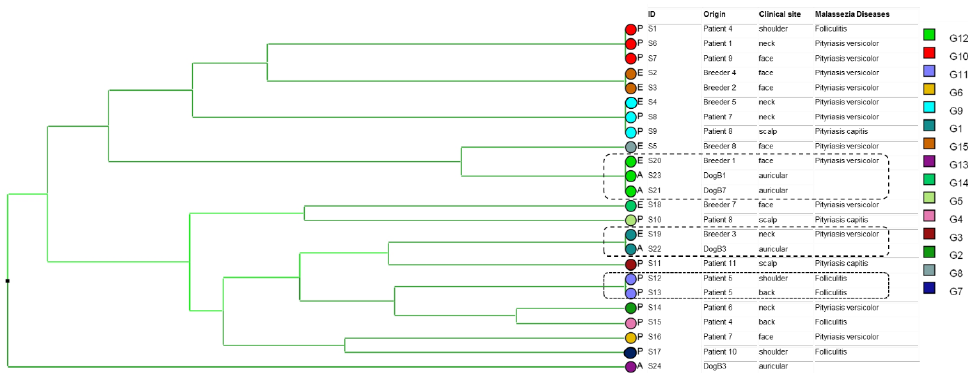
Figure 2. UPGMA dendrogram upon analysis of six VNTR markers obtained from 24 Malassezia restricta isolates. P: patient, A: animal and E: breeder. The highlighted isolates illustrate: for P5 (square with dotted-line border), isolates collected from the different clinical sites from the same patient share the same genotype. For isolates highlighted by a square with a dashed-line border collected from breeders and their dogs, present the same genotype indicating an animal–human co- transmission. The calculated genetic diversity per locus (FST) values for the three populations of M. globosa strains ranged from 0.018 to 0.057, indicating weak differentiation between them (Table 2). These results suggest a dominant clonal mode of reproduction in M. globosa . Table 2. M. globosa F st values comparing patients, breeders and animals genotypes. Pop E